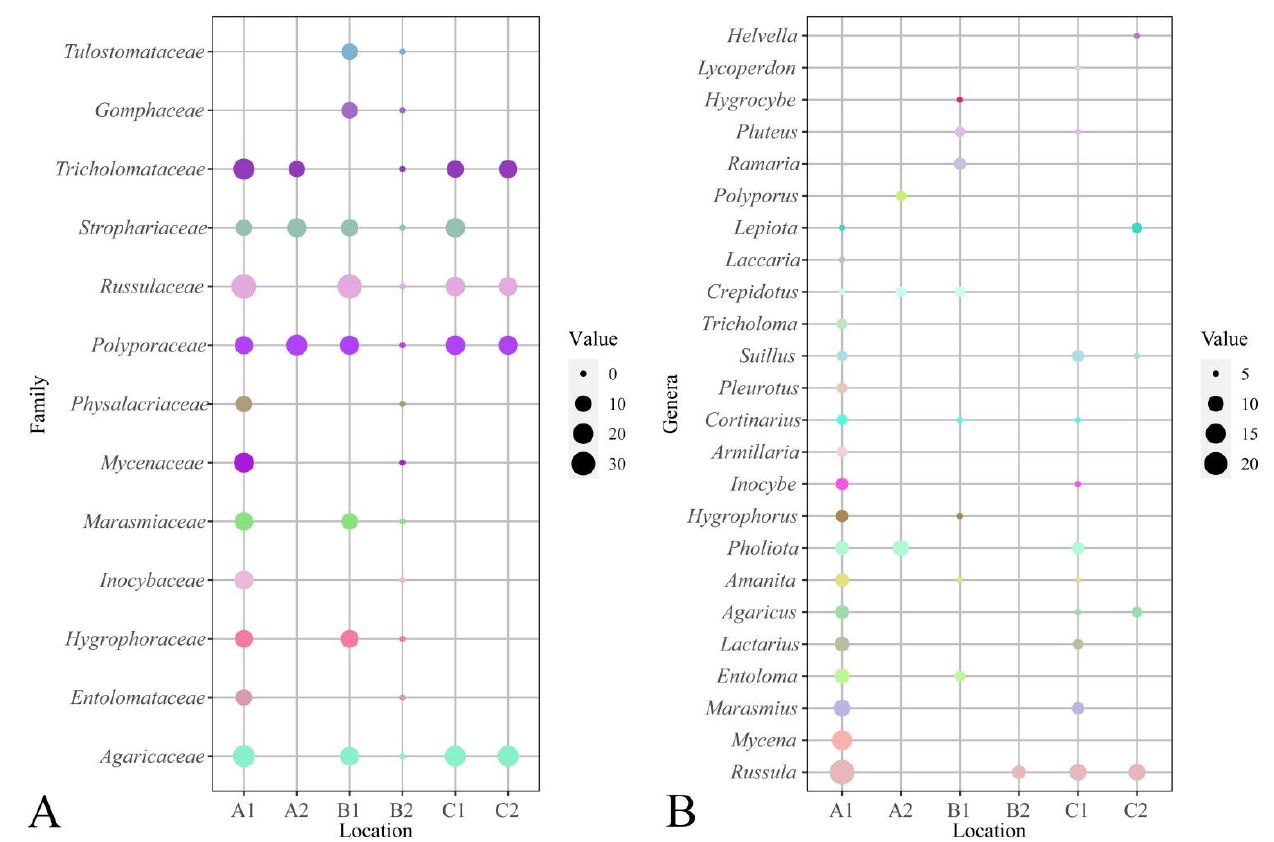
Figure 8. Dominant families and genera of six investigation sites from Jilin Province. ( A ) Dominant families (number of species more than ten of the family) analysis of six investigation sites from Jilin Province. ( B ) Dominant genera (number of species more than five of the genera) analysis of six investigation sites from Jilin Province. The results show site A1 contains more dominant families and genera in six investigation sites; in contrast, site B2 includes few. A1: Quanshuidong Forest Farm; A2: Lushuihe National Forest Park; B1: Shengli River Forest Farm; B2: Longwan National Forest Park; C1: Zuojia Region; C2: Jingyuetan National Forest Park. Table 4. Top 10 families and genera in six different investigation sites from Jilin Province.